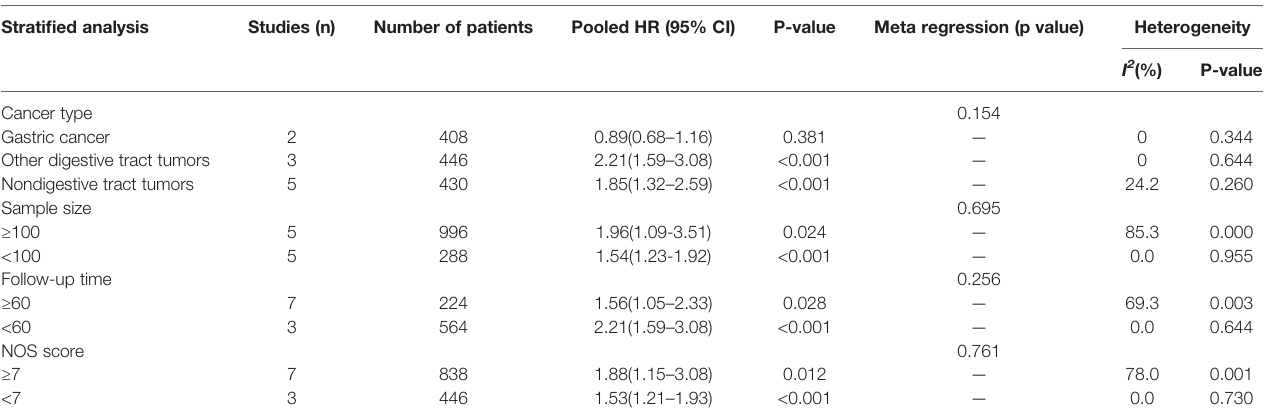
TABLE 2 | Subgroup meta-analysis of pooled HRs for OS.